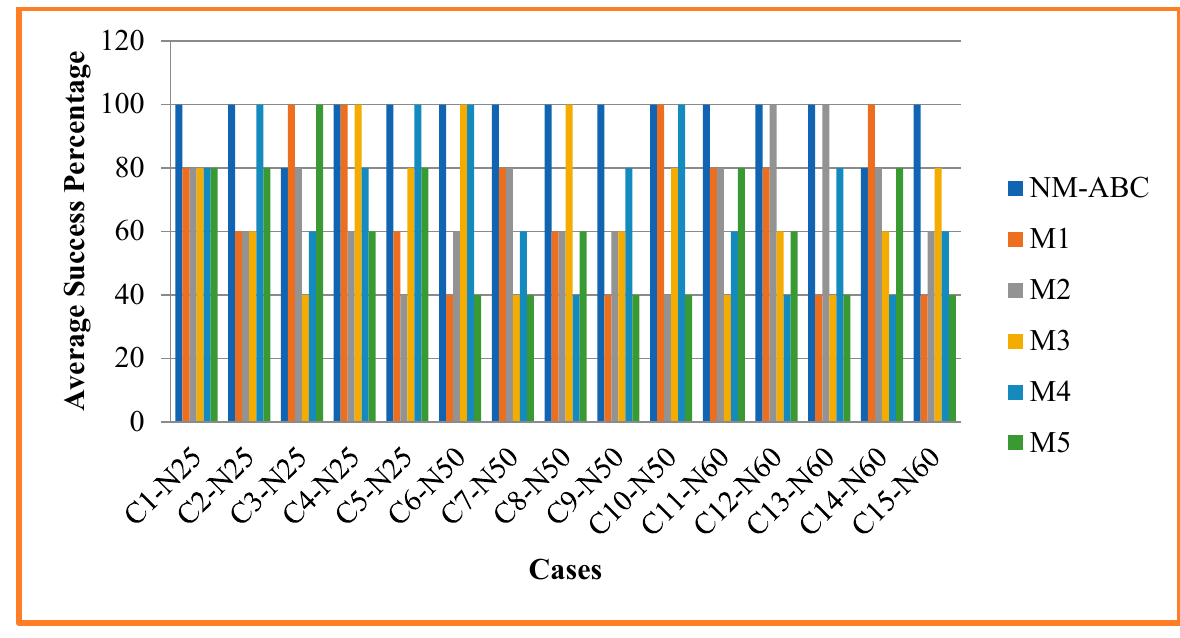
Figure 5. Analysis and Comparison of Average Success Percentage. Table 7. Comparison and assessment of ACR and AGap obtained by proposed algorithm NM-ABC and competitor methods.